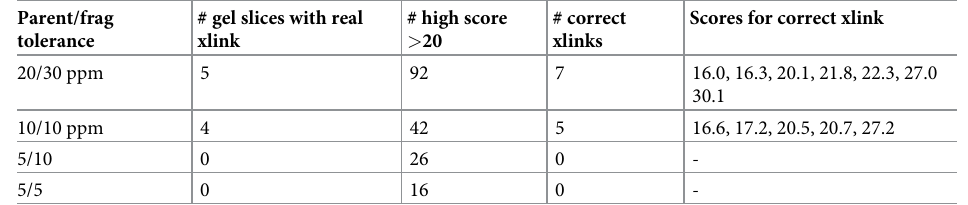
Table 1. Relationship between search tolerance and number of xlink